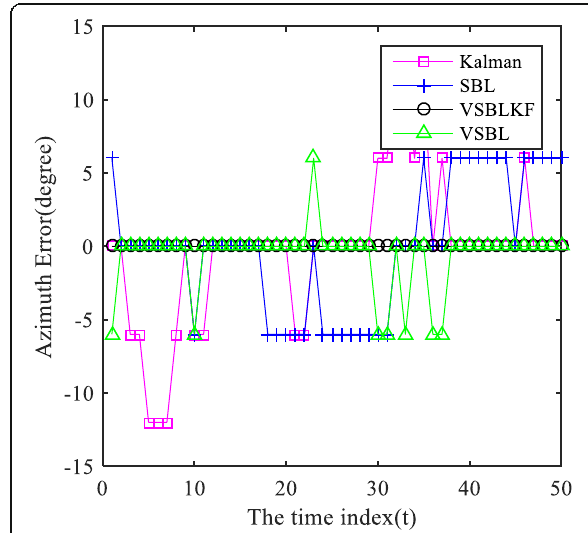
Fig. 7 Azimuth error as a function of time